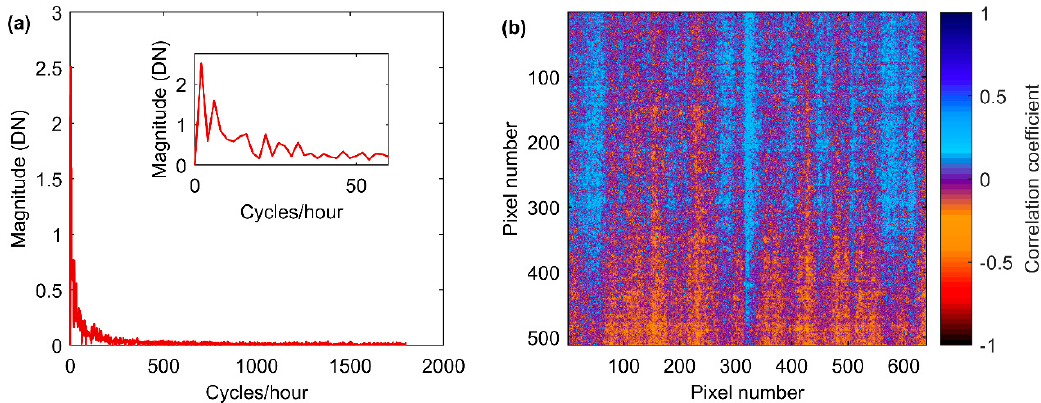
Figure 5. ( a ) Frequency magnitudes of sensor noise over 30 min (1 image/second, n = 1800) using Fourier transform (see Section 2.1.4). The inset shows the highest magnitude frequencies. ( b ) Pearson’s correlation coefficients between every pixel and the central pixel on the sensor. Neighboring pixels with similar coefficients exhibited similar patterns of deviation of DN from the image mean DN (i.e. non-uniformity noise).